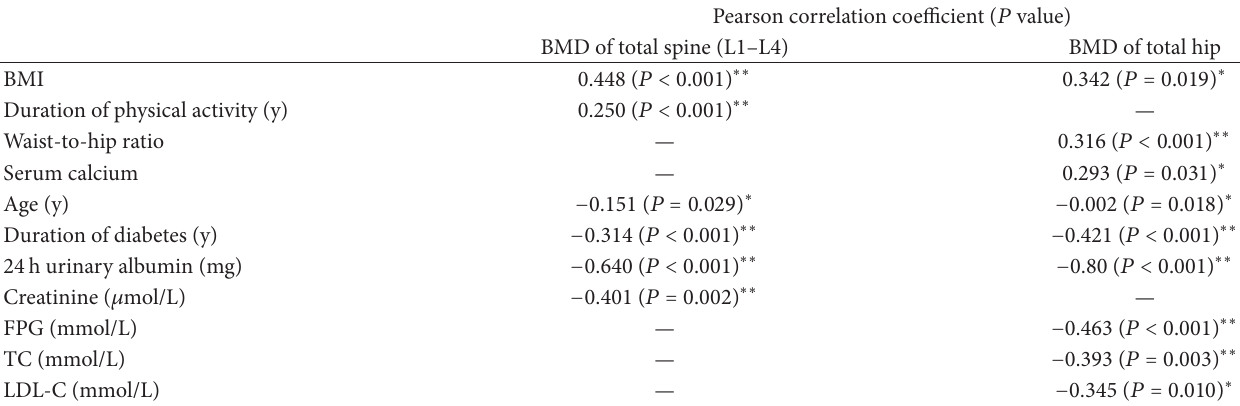
T 5: Correlations betwteen T2DM-related factors and